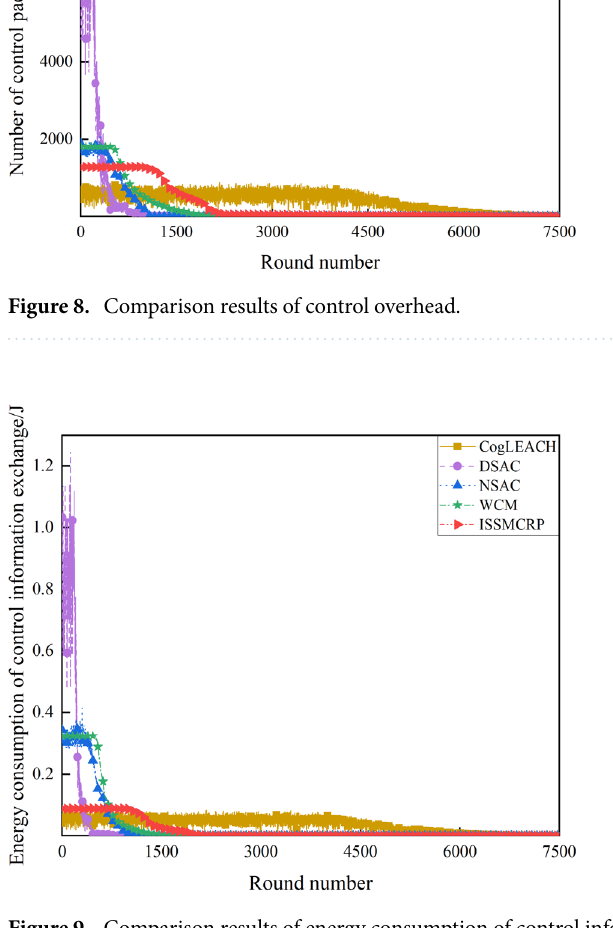
Figure 9. Comparison results of energy consumption of control information